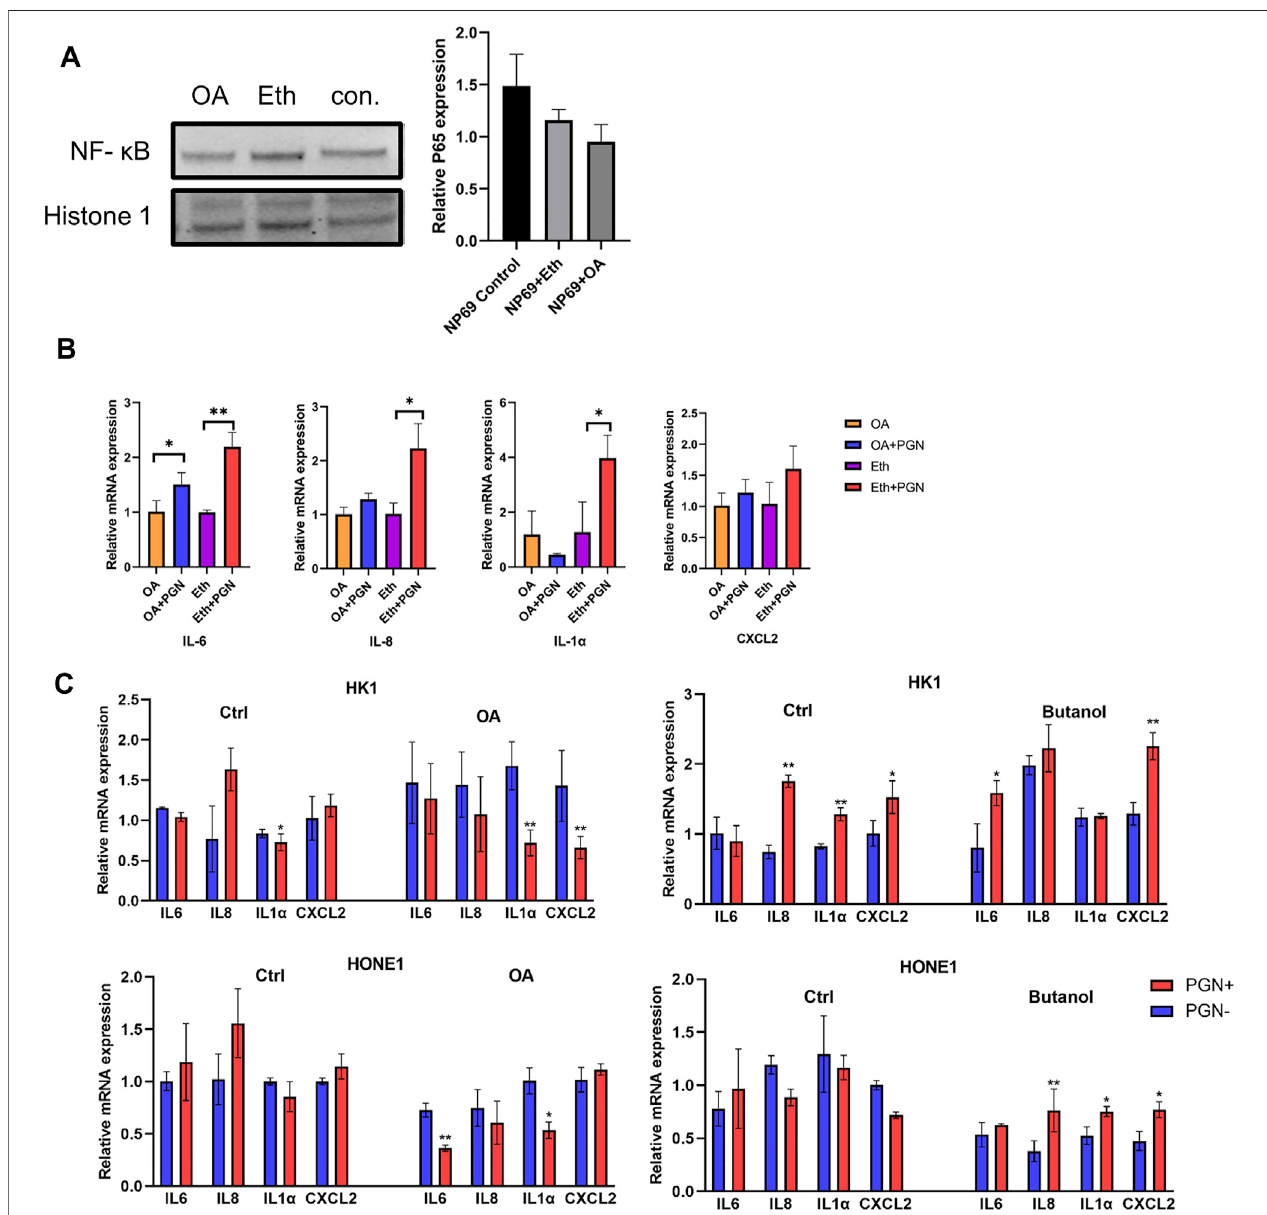
FIGURE5| Intracellular amountofLDs affects thenucleartranslocation ofNF- κ B(p65). (A) NNEcell lineNP69 wastreatedwitholeic acid(OA)for48 h toincrease intracellular LDs. The NF- κ B (p65) expression in the nuclear fraction from NP69 cells was analyzed using Western blot. (B – C) : Transcriptional level of pro-in fl ammatory cytokinesIL6,IL8, IL1 α ,and CXCL2wasnegativelycorrelatedwiththeintracellular amountofLDsinnoncancerousnasopharyngeal epithelialcellsand NPC-derived cell lines, before and after stimulation with 10µg/mL of PGN for 2 h * p < 0.05; ** p < 0.01.